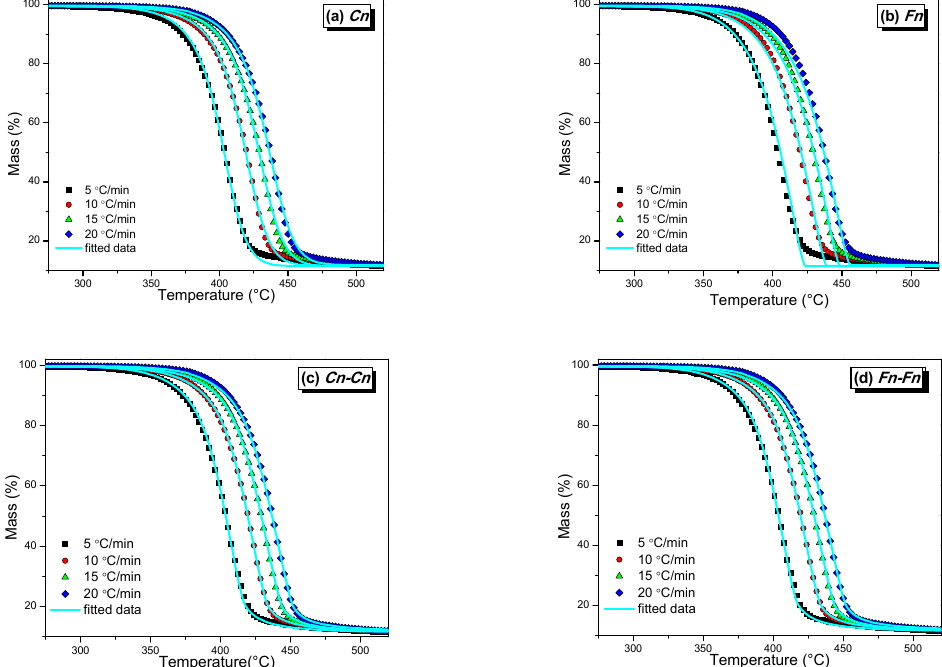
Figure 14. Mass loss (%) and fitting curves of PEV for different heating rates β = 5, 10, 15 and 20 °C/min in nitrogen atmosphere ( a ) using the Cn model, ( b ) using the Fn model, ( c ) using the Cn–Cn model, ( d ) using the Fn–Fn model. Table 1. Results of the model-fitting method for PEV.